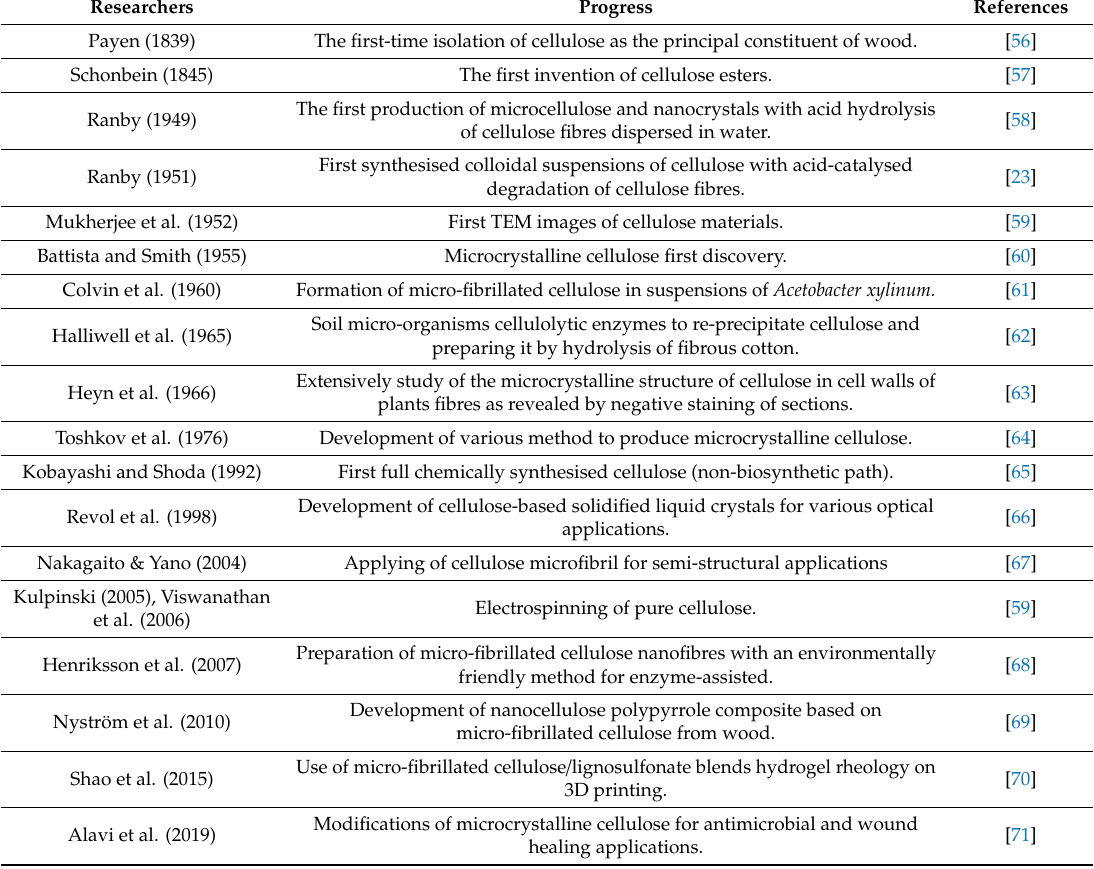
Table 3. Chronological summary of the research trends on microcellulose-based